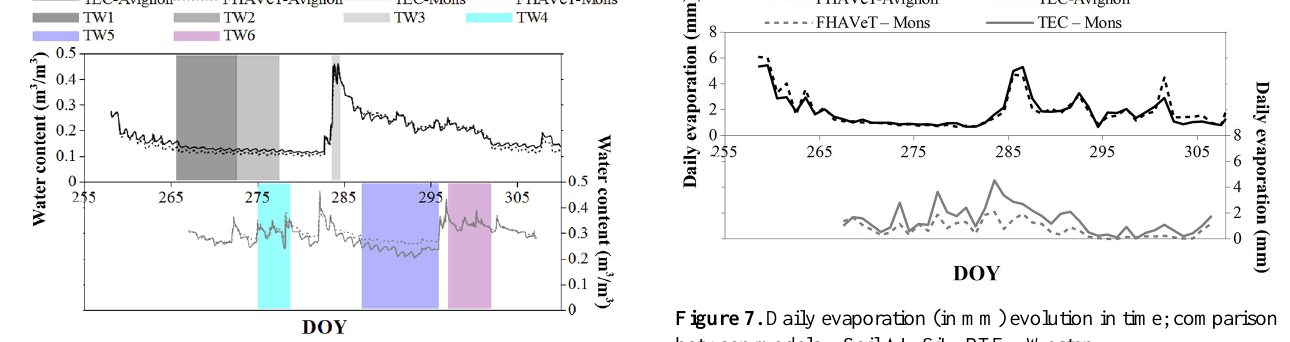
(0–5 and 0–30 cm) for both models over each time window.